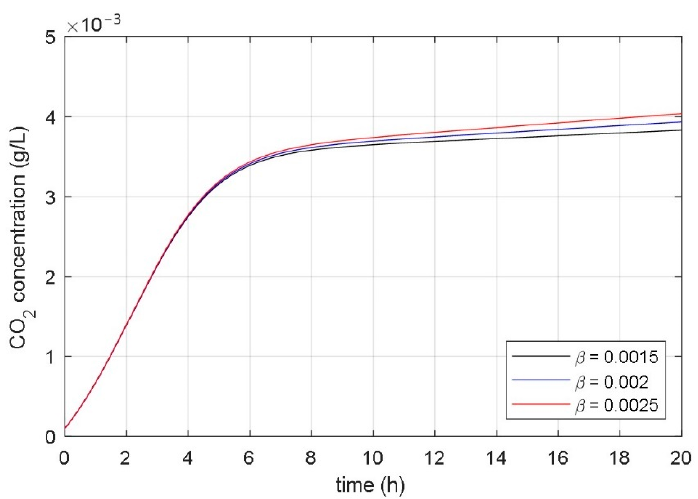
Figure 8. The impact of the parameter α on the time course of the CO 2 concentration.